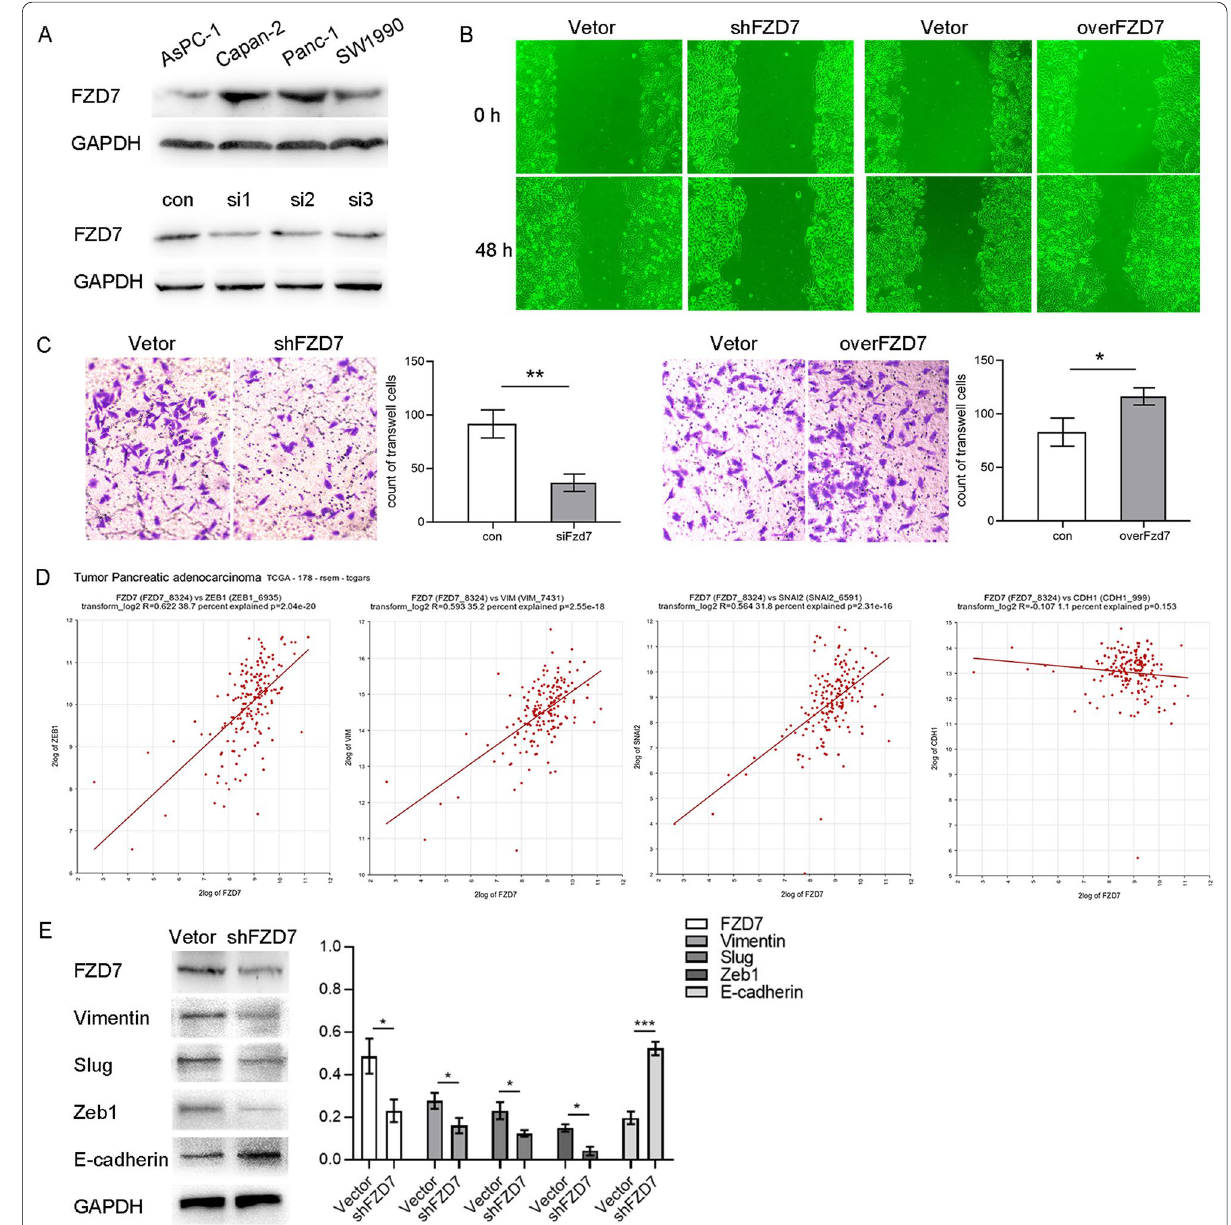
Fig. 3 PANC-1 was selected for experimentation in vitro, and the effective siRNA was screened by Western blot ( A ). Silencing FZD7 suppressed PANC-1 cell migration and invasion in Wound healing and Transwell assays ( B ); whereas FZD7 over-expression promoted PANC-1 cell migration and invasion in Wound healing and Transwell assay ( C ). In human PDAC, FZD7 gene expression was significantly positively correlated with that of the mesenchymal-related genes, ZEB1 , VIM , SNAIL2 , with Pearson co-efficients of 0.622 ( P respectively, and non-significantly negatively correlated with the epithelial-related gene CDH1 ( P of FZD7 was down-regulated by siRNAs, the expression of ZEB1, Vimentin and Slug proteins were all reduced with statistical significance ( E ). Significant, * P < 0.05, ** P < 0.01, *** P < 0.001, Student’s